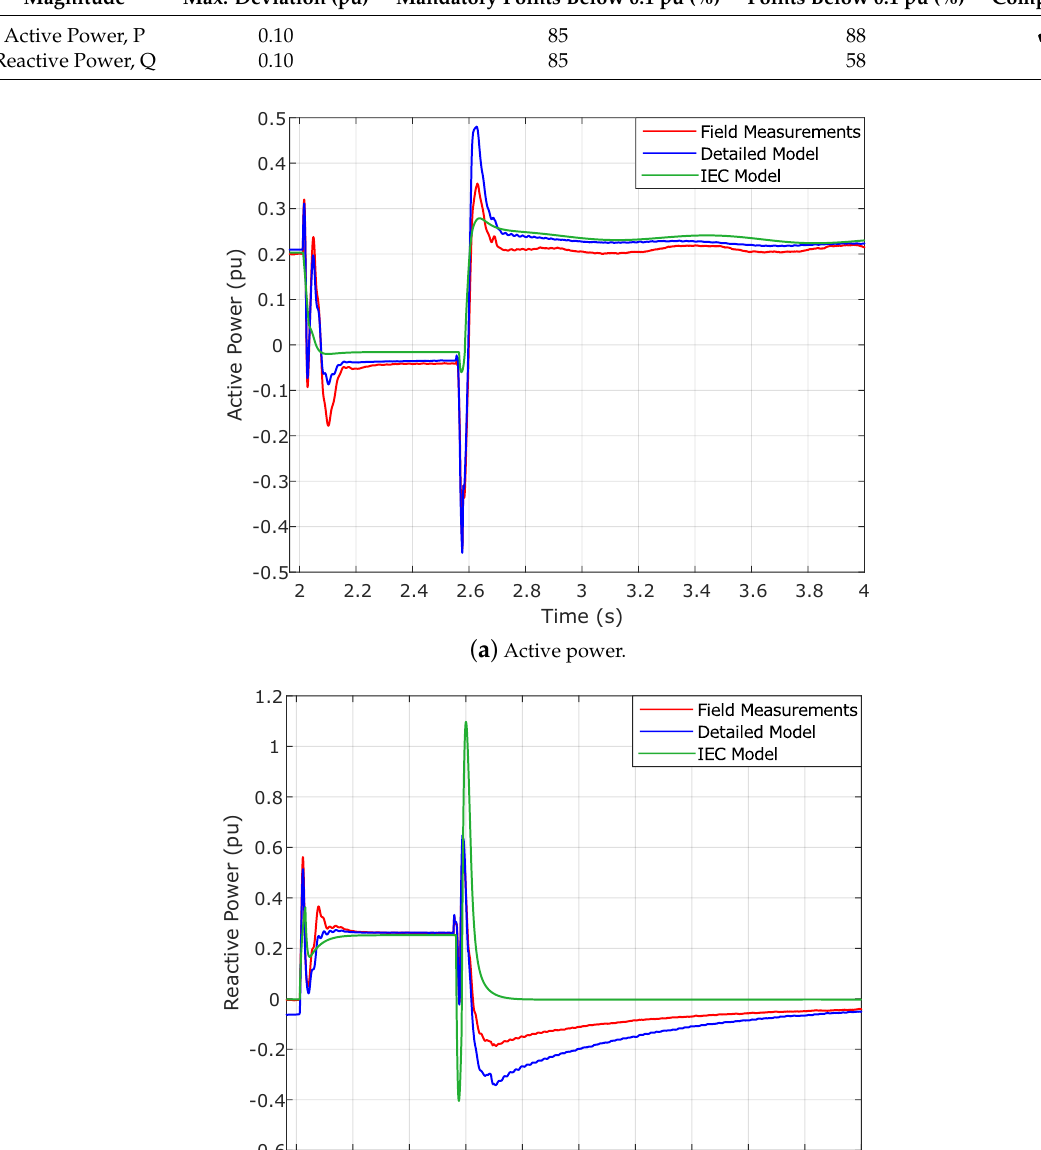
Table 6. Verification of the PVVC validation criteria applied to the IEC generic WT model at the testing point, operating at partial load conditions: 20 kV, measurement point 1.